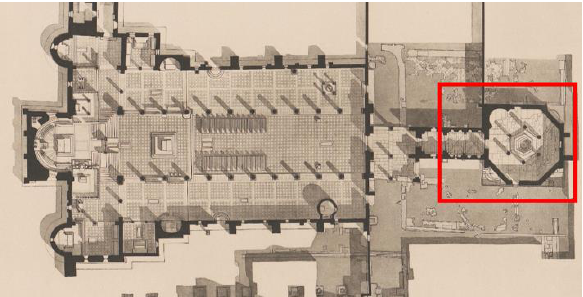
Figure 6. Lanckoronski plan. Red line identifies the Baptistery